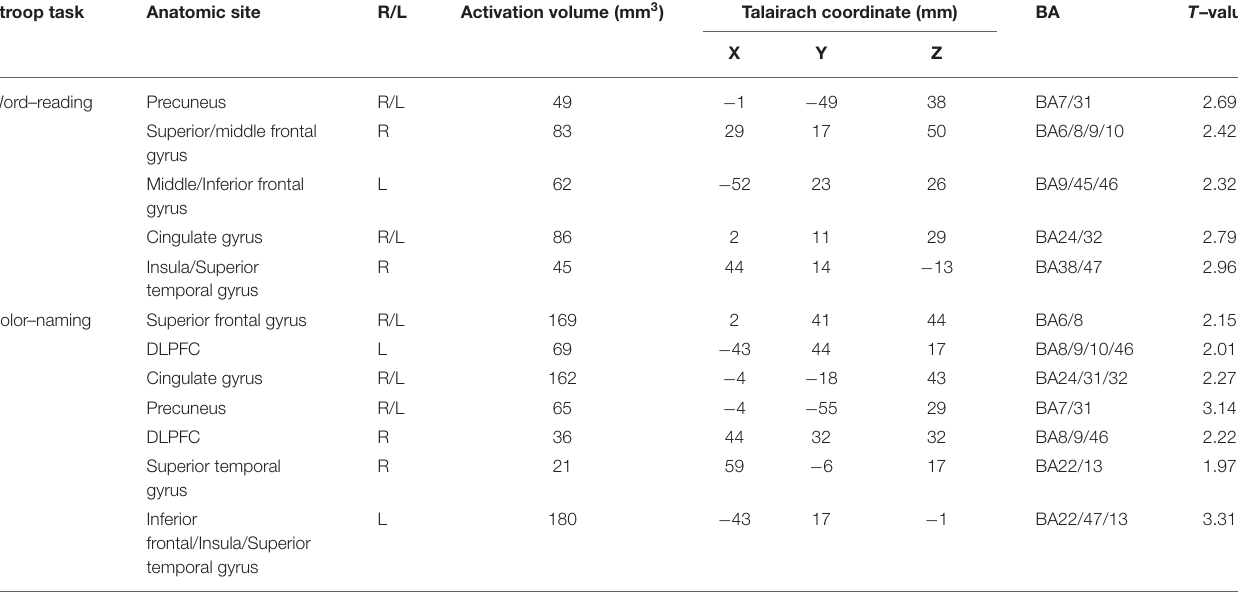
TABLE 6 | Brain activation differences of groups in the Stroop task (control group vs. SCH group). Stroop